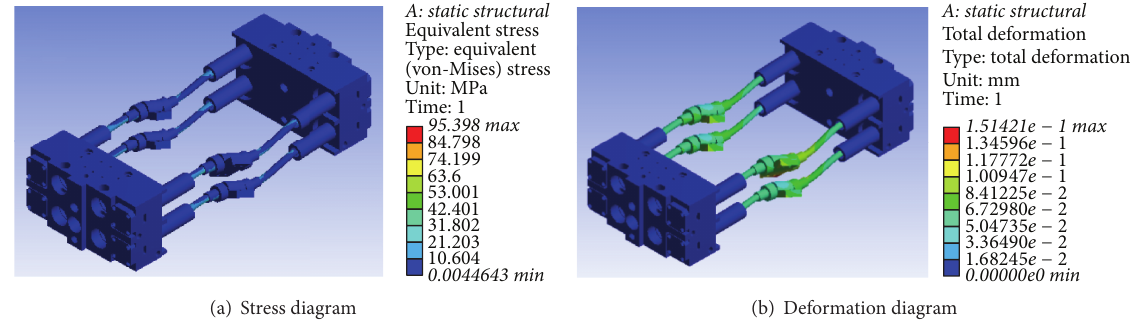
Figure 4: Stress and deformation